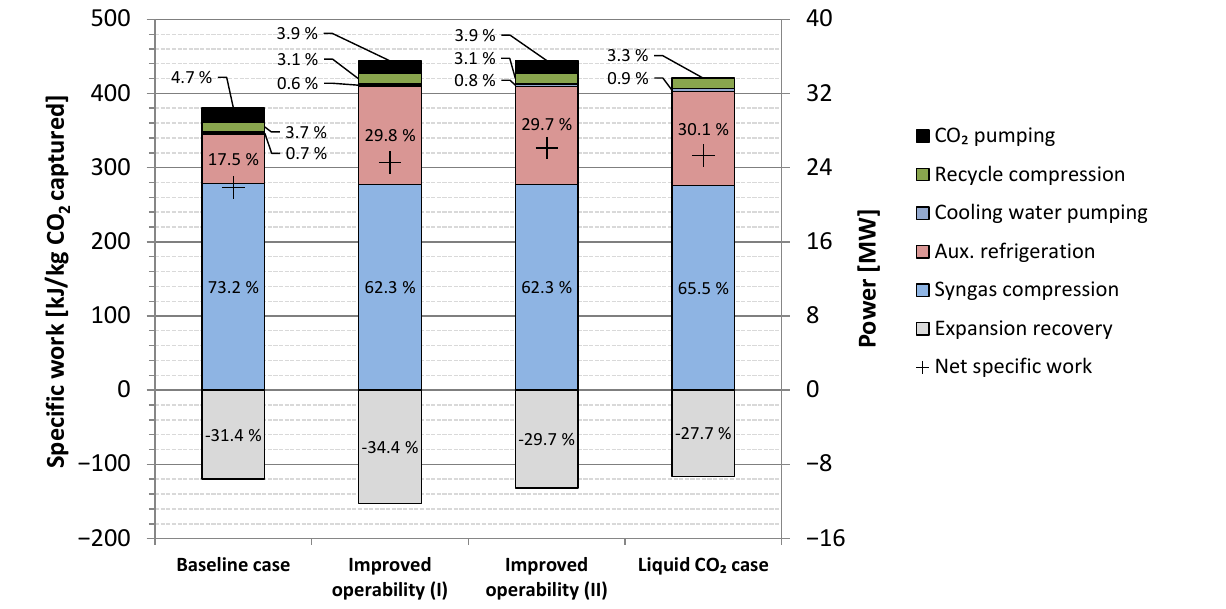
Figure 15. Power figures for the baseline case, improved operability cases and liquid CO 2 case for ship transport. The percentage of each power component relative to the gross power requirement for each case is also shown.